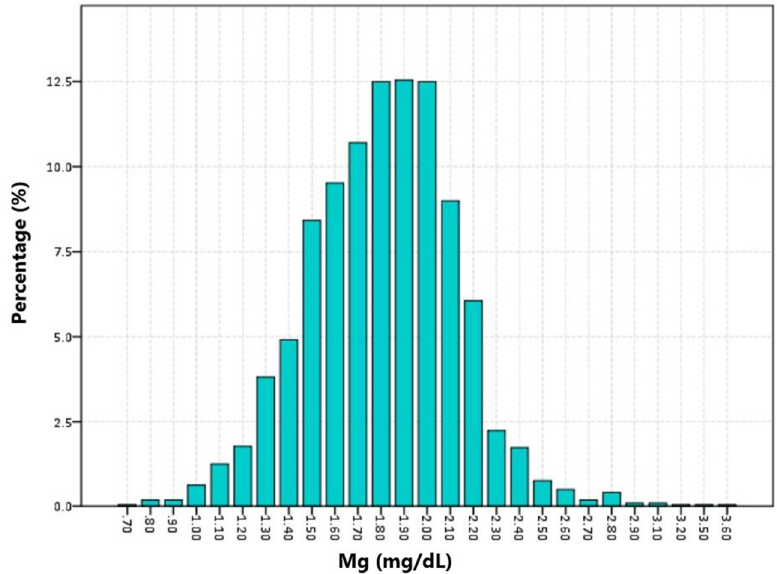
Figure 2. Distribution of initial serum magnesium level in included TBI patients.